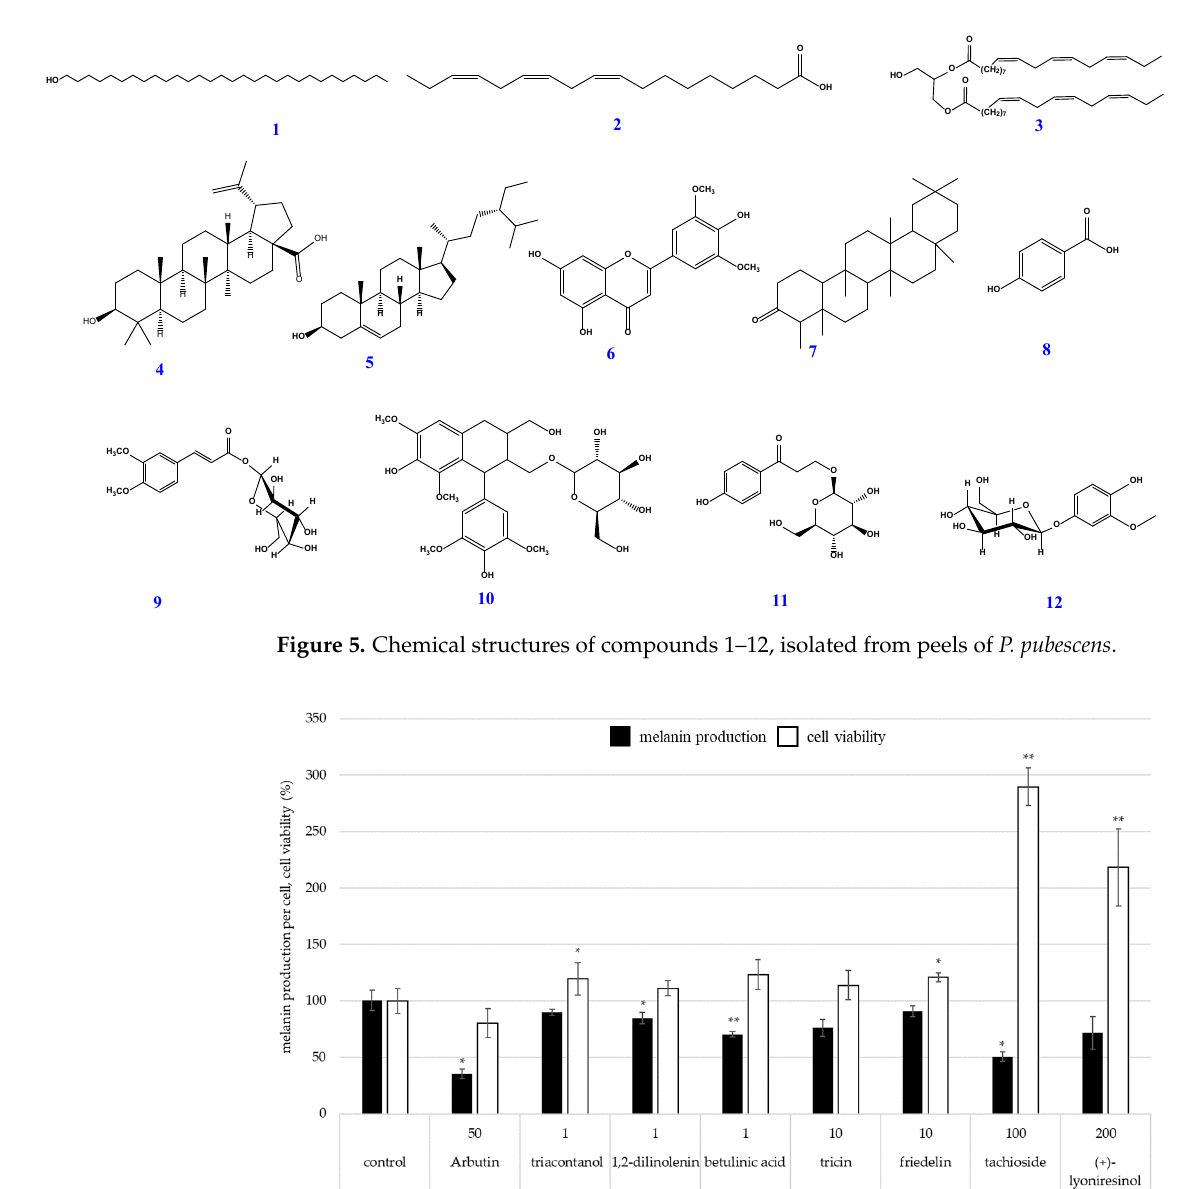
Figure 6. The inhibitory effect of isolated compounds from bamboo peel extract on melanin synthesis in B16 melanoma cell (* p < 0.05 and ** p < 0.01). Triacontanol, tricin, and (+)-lyoniresinol 9 (cid:48) -o-glucoside also tended to decrease melanin production per cell (Figure 6). In addition, 1,2-dilinolenin, betulinic acid, and tricin did not have an effect on cell viability. In the case of application of tachioside or (+)-lyoniresinol 9 (cid:48) - O -glucoside, cell viability was higher than control (Figure 6). Thus, each isolated compound from P. pubescens skin has a suppression effect on melanin production because of increasing cell